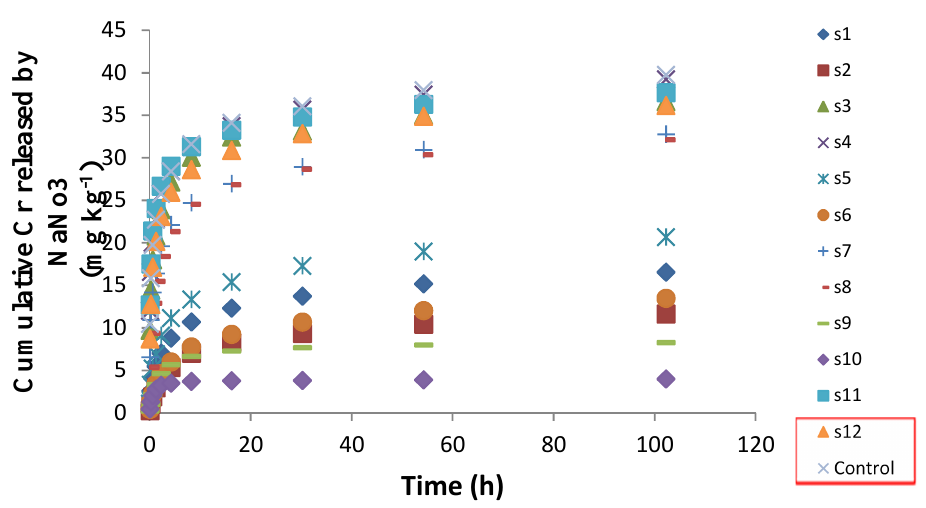
in time in treated 3